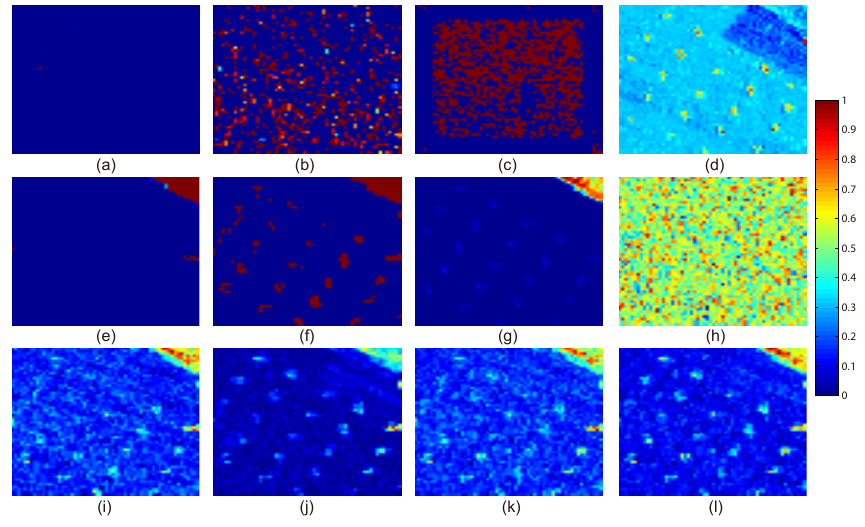
Figure 4. The visualization results of different detectors on AVIRIS1 data set. ( a ) LRX: window size (17,9); ( b ) SRD: window size (13,7); ( c ) CRD: window size (15,7); ( d ) LSMAD; ( e ) RSAD; ( f ) BACON; ( g ) BACON-target; ( h ) GKRX; ( i ) GRX; ( j ) PCA-GRX; ( k ) Ours-withoutMV; ( l ) Ours. Values in the color bar represent the anomaly